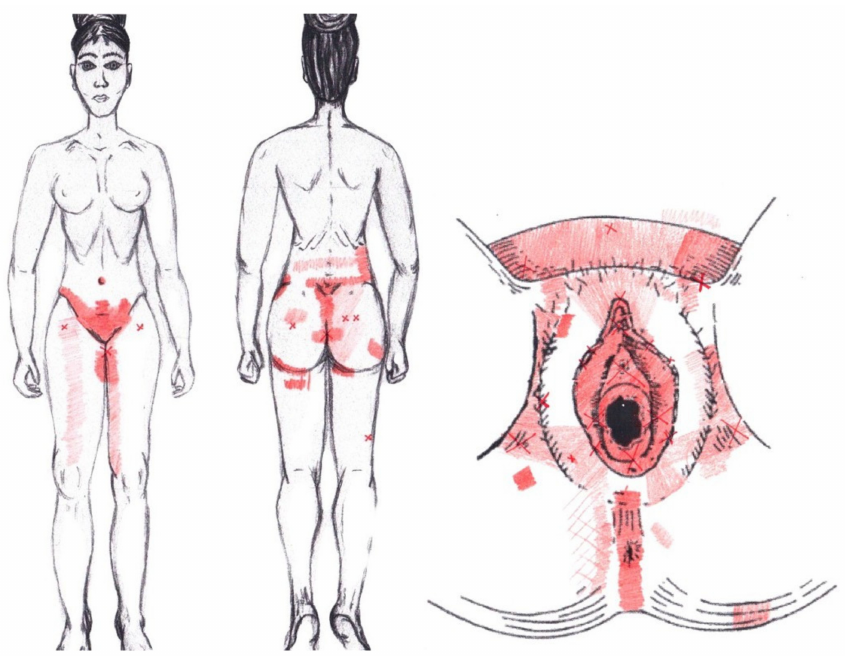
Figure 17. Graphical simulation of referred pain areas of the iliococcygeus muscle.